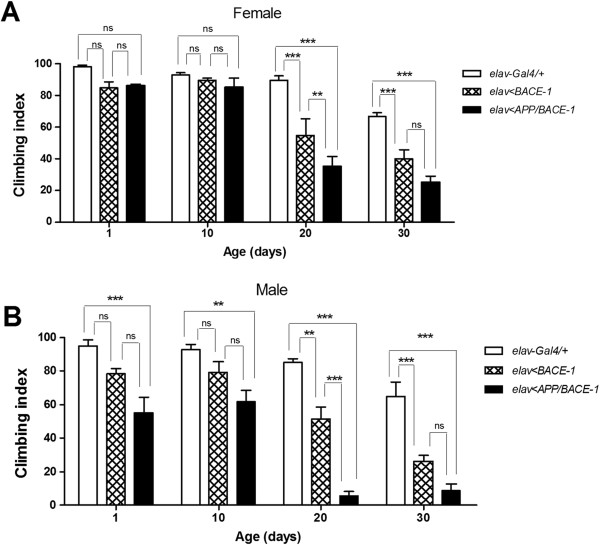
Climbing behavior of females (A) and males (B) from elav-Gal4/+, elav < BACE-1, and elav < APP/BACE-1 fed standard media. (n = 50–100 flies ***: p < 0.001, **: p < 0.01, ns: no significant difference). Each bar represents standard error.